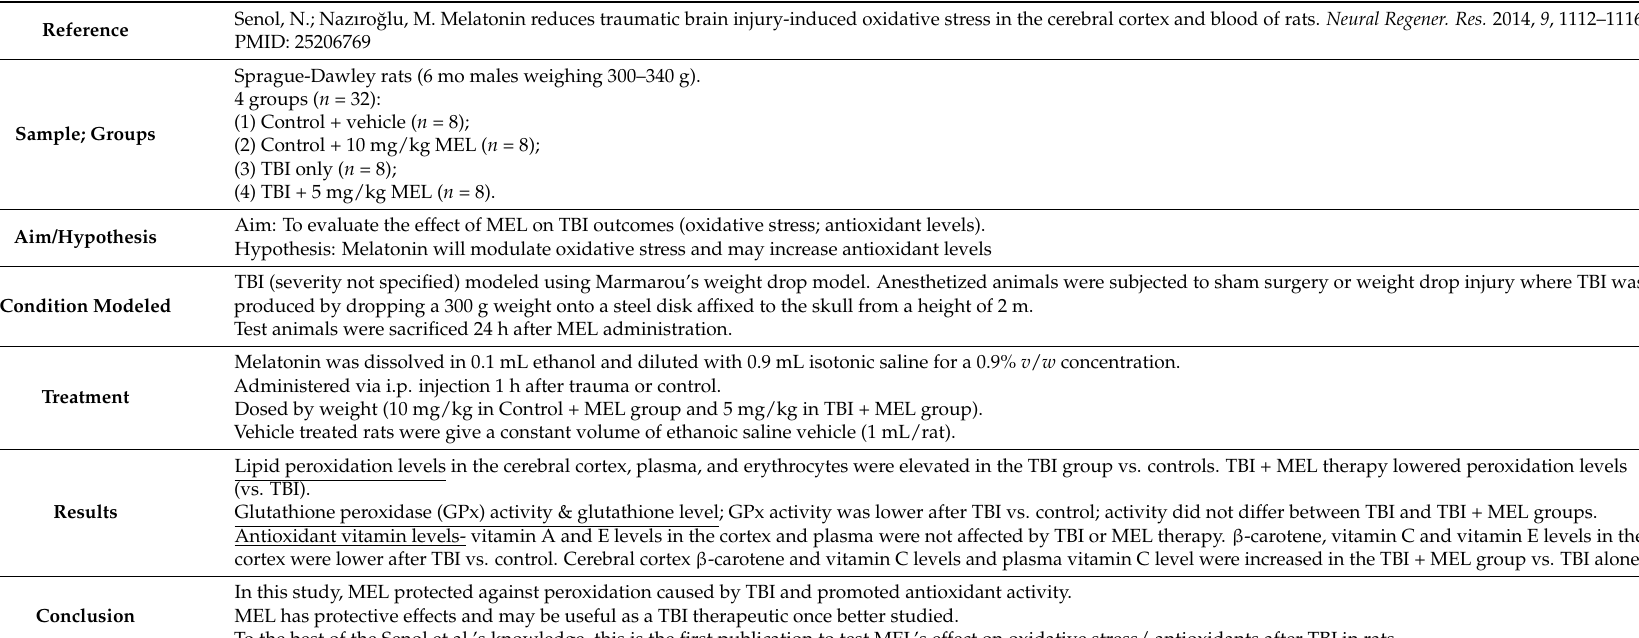
Table A14. Senol et al. (2014) Study